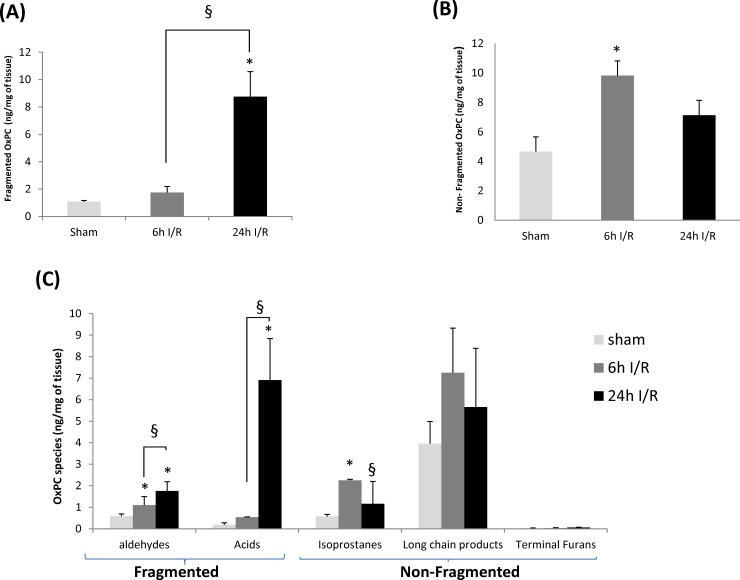
OxPC subgroups classified by fragmentation pattern and species in sham, 6h and 24h I/R groups.Total (A) fragmented OxPC, (B) non-fragmented OxPC and (C) OxPC by species in sham (light gray bar), 6h I/R (dark gray bar) and 24h I/R (black bar) groups. * Significant difference compared to sham, P<0.05. § Significant difference between I/R groups, P<0.05. Abbreviation: OxPC: Oxidized phosphatidylcholine.